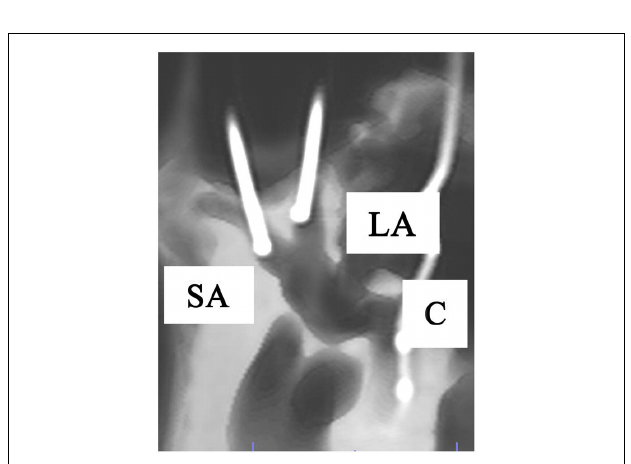
FIGURE 1 | Lateral view of a right temporal bone. It shows the superior canal (SC), lateral canal (LC), and posterior canal (PC) which are fenestrated near the ampullary ends and marked with inserted plastic wires. Line X is the imaginary line through the stapes footplate, which indicates the location of the posterior ampulla, medial to the facial nerve.